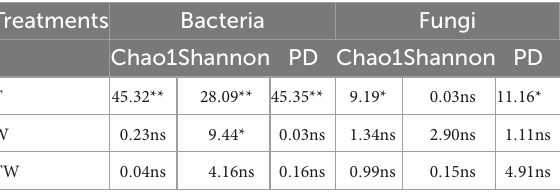
TABLE 1 Multifactor ANOVA of bacterial and fungal diversity affected by increasing temperature (T), increasing precipitation (W), and their interaction